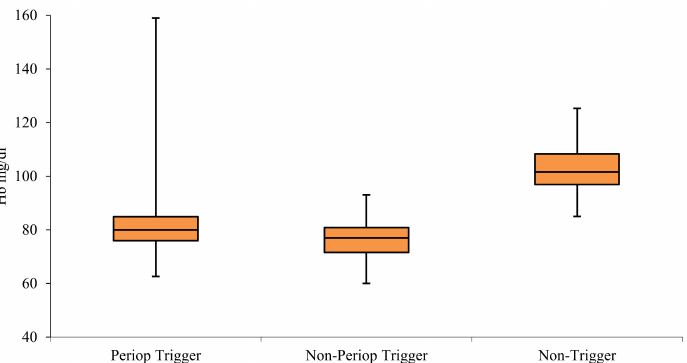
Figure 2. Comparison of perioperative and non-perioperative haemoglobin triggers for transfusion, and average of lowest haemoglobin values that did not trigger a transfusion in surgical patients. Differences between transfused and non-transfused patients by gender are outlined